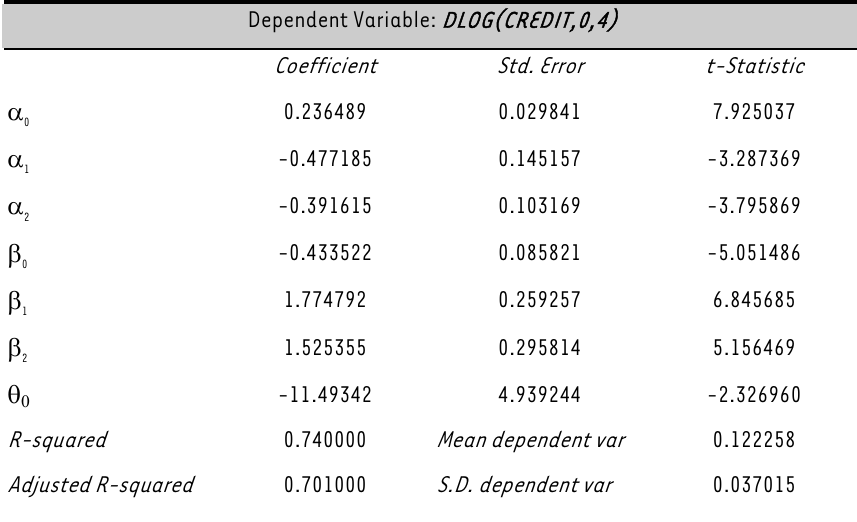
TABLE 4: Results of the LSTAR Model for